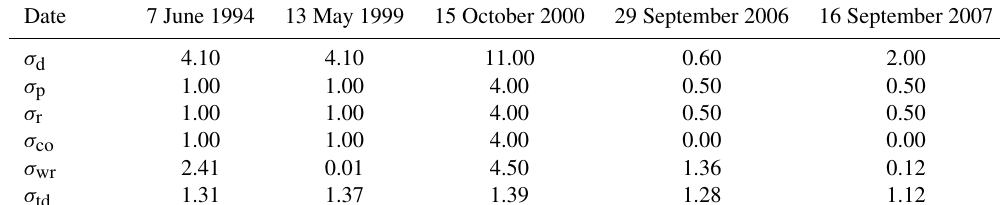
Table 6. Uncertainties determined for the shoreline position (m). The total uncertainties are in bold